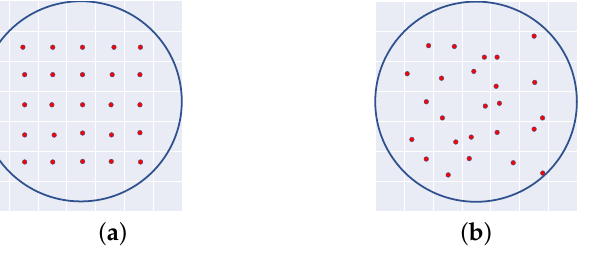
Figure 4. ( a ) Spots distribution on SHWS without distortion. ( b ) Spots distribution on SHWS with